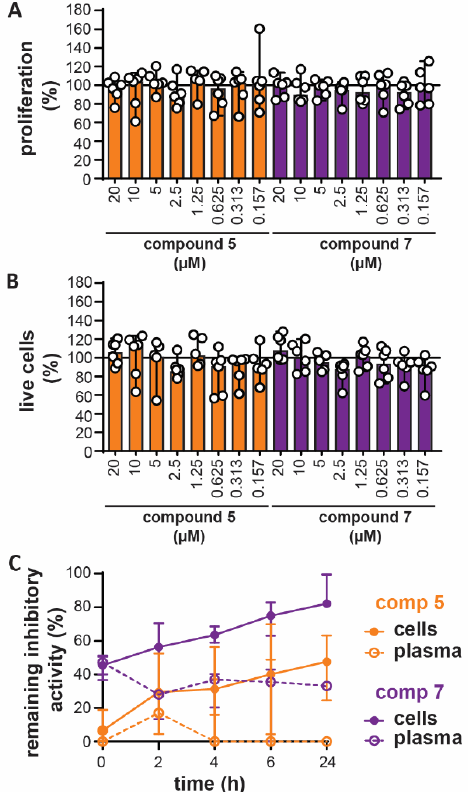
Figure 3. In vitro toxicity and ex vivo stability of compounds 5 and 7 . ( A ) E ff ect of compounds 5 and 7 on the proliferation of U-87 cells. Data represent 17 h of growth in the presence of indicated concentrations of the compounds and in comparison with cells grown without compounds ( n = 5–6); ( B ) e ff ect of compounds 5 and 7 on the cell viability of U-87 cells grown for 17 h in the presence of indicated concentrations of the compounds and in comparison with cells grown without compounds. ( n = 5–6); ( C ) evaluation of the ex vivo stability of the compounds by measurement of the remaining MMP-9 inhibitory activity after addition of the compounds to mouse blood for the indicated period. Inhibitory activity present in the plasma (open circles, dotted lines) and cell lysates (closed circles, solid lines) was evaluated ( n =